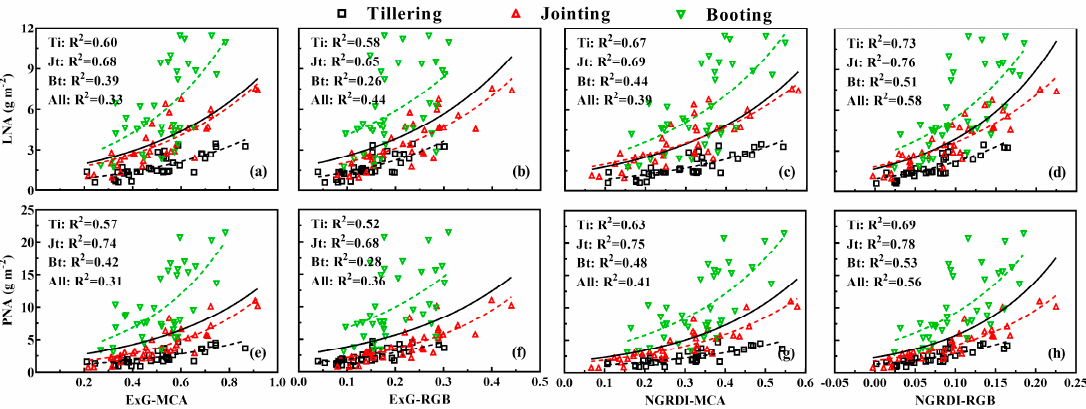
of N top-dressing fertilization. DAT denotes days after transplantation.